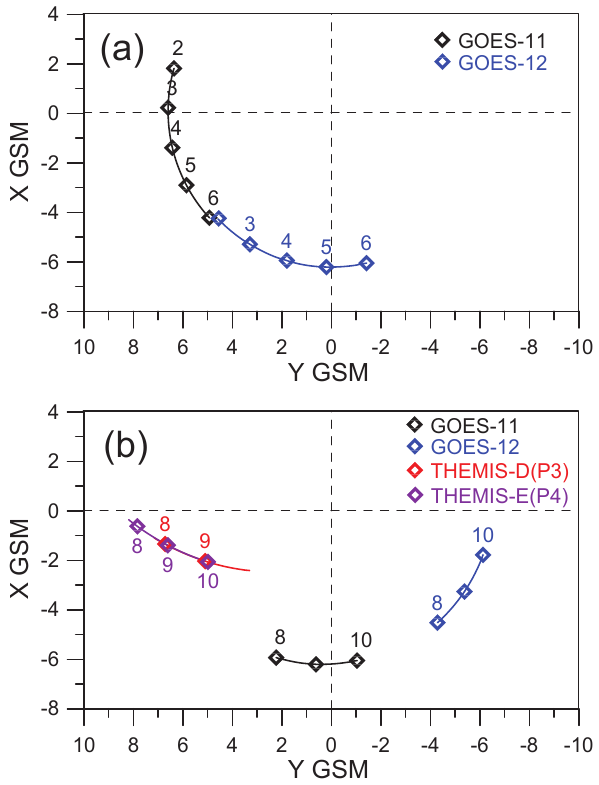
Fig. 2. Projection of spacecraft orbits on the XY GSM plane. (a) The first Sym-H ∗ dip period (02:00–06:00UT), (b) second Sym- H ∗ dip period (08:00–10:00UT). The colors correspond to different